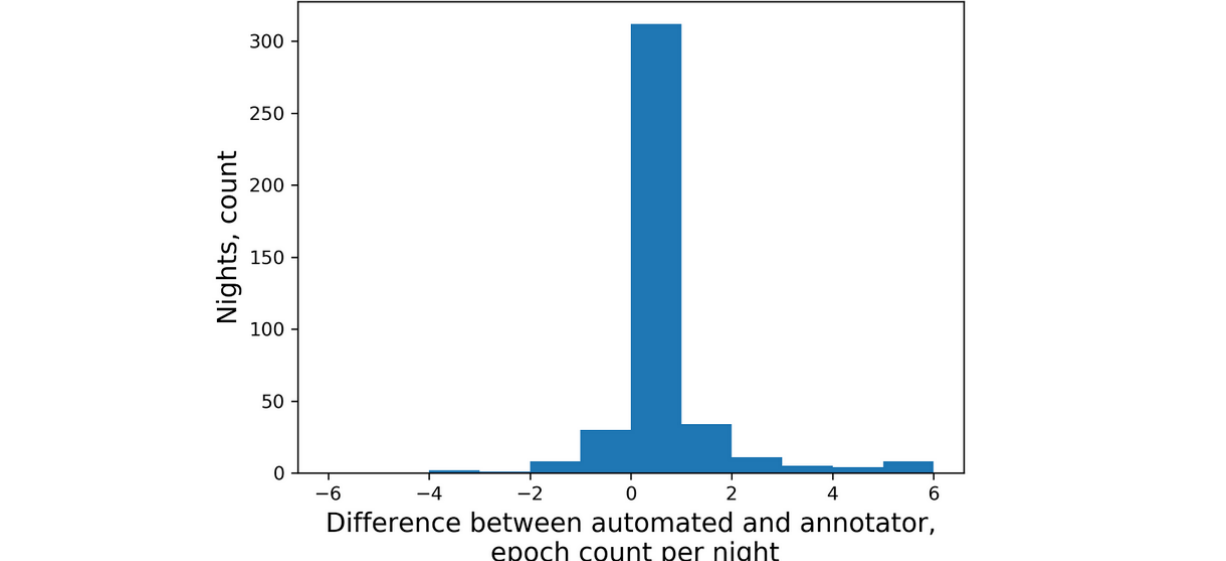
Figure 7. Histogram of the differences between automated and annotator cough-epoch counts per night.